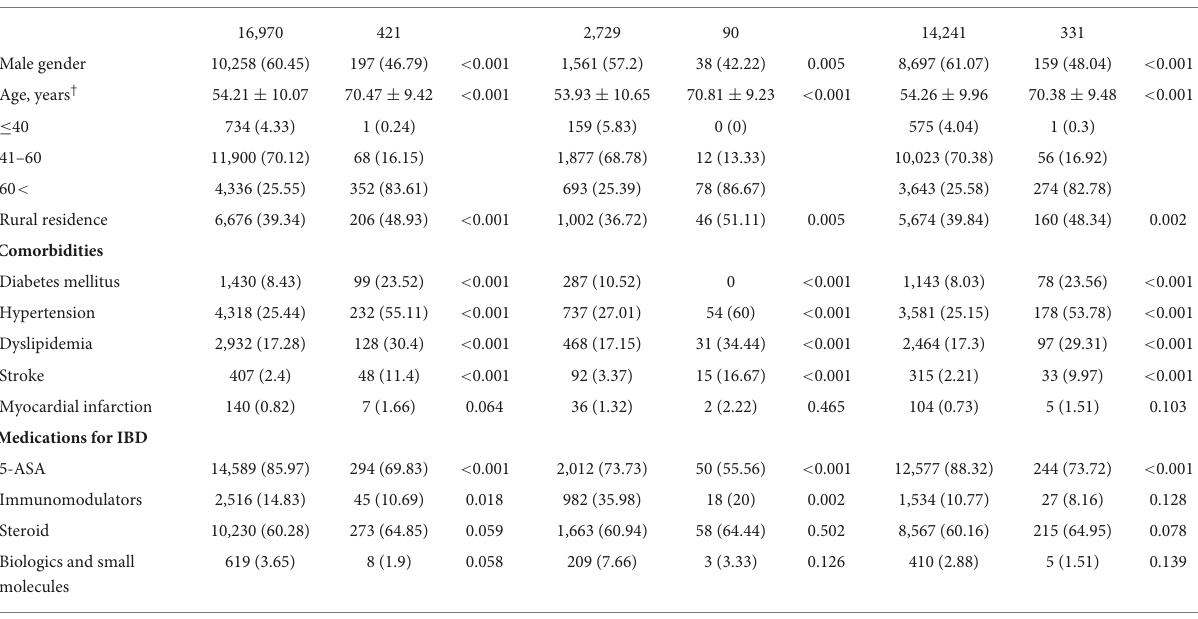
TABLE 1 Baseline characteristics of the study population in development of dementia on inflammatory bowel disease (IBD).